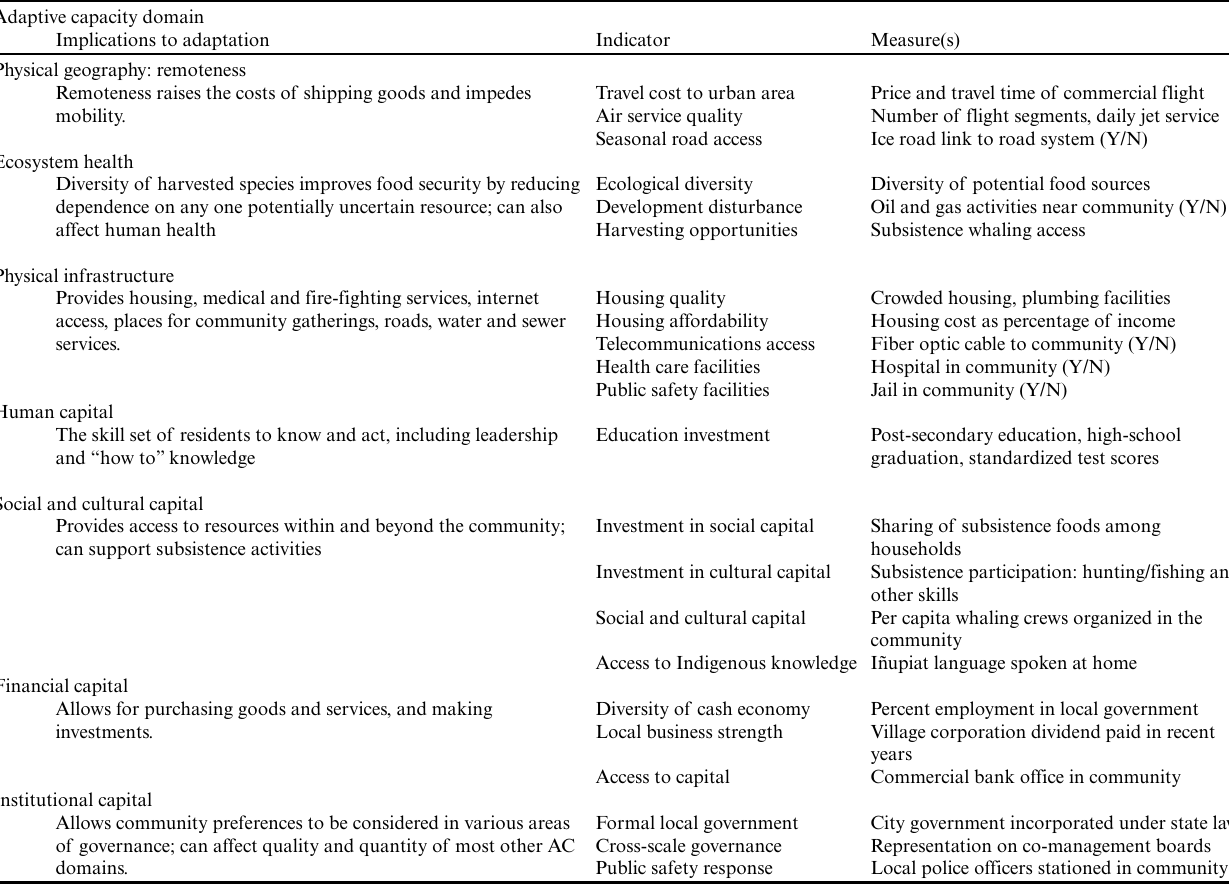
Table 1 . Domains, implications to adaptation, and indicators of adaptive capacity for Alaska North Slope